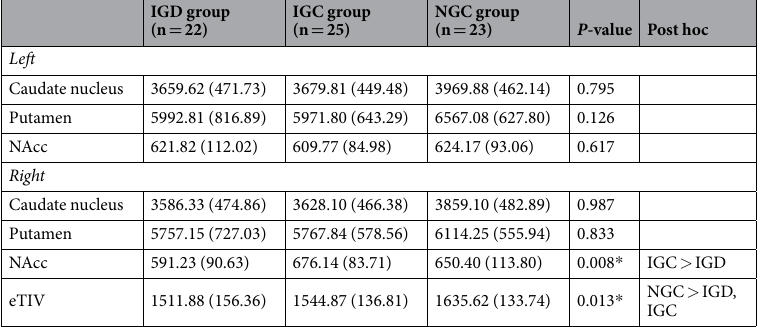
Table 2 and Figure 2 represent the striatal volumes obtained from FreeSurfer. The estimated total intracra- nial volume (eTIV) was different among the three groups ( P = 0.013) but not between the Internet gaming user groups ( P = 0.430). Although the volumes of the bilateral caudate nucleus and putamen were not significantly dif- ferent among three groups (Table 2; left caudate nucleus, P = 0.795; left putamen, P = 0.126; right caudate nucleus, P = 0.987; right putamen, P = 0.833), Figure 2 illustrates a distinct difference between the Internet gaming groups and NGC group by presenting the results of the comparisons of the standardized striatal volumes. The Internet gaming groups showed negative values in the volumes of the bilateral dorsal striatum, consisting of the caudate nucleus and putamen, compared with the NGC group that showed positive values. We found that the volume of the right NAcc, adjusting for age and eTIV, was significantly different among the three groups, and this difference still survived a more stringent correction for multiple comparisons. A post hoc analysis revealed that this volu- metric difference was driven by the smaller volume in the IGD group than that in the IGC group. Relationship between the structural measurement and IGD characteristics. The correlation anal- yses were performed merging the IGD and IGC groups together to explore the relationship between the structural measurements and IGD-related characteristics (Table 3). The GM density in the left DLPFC, detected in the VBM analysis, was negatively correlated with IGD severity, lifetime usage of Internet gaming, depression, craving, and